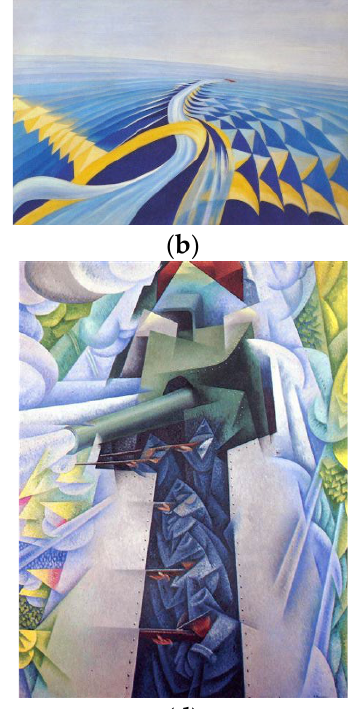
Figure 3. Four examples of Futurism art images. ( a ) “The Revolt,” by Luigi Rossolo, 1911. ( b ) “Speeding Motorboat,” by Benedetta Cappa, 1923. ( c ) “Mercury Passing Before the Sun,” by Giacomo Balla, 1914. ( d ) “Armored Train in Action”, by Gino Severini, 1915.